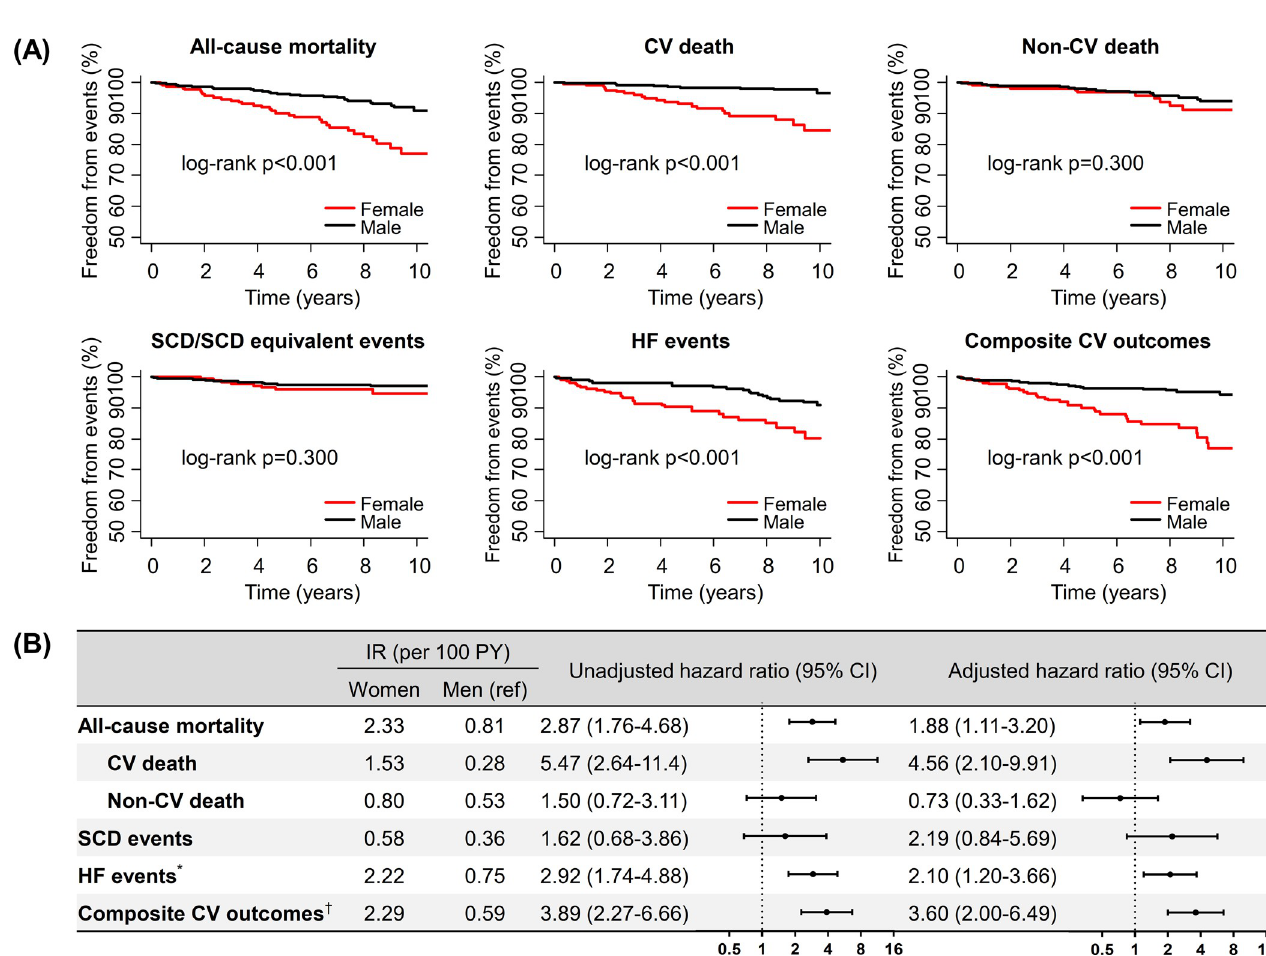
Fig 1. Sex differences in clinical outcomes. (A) Sex differences of event-free survival curves for clinical outcomes. (B) Independent association of sex with various outcomes. Multivariable adjustment was performed for age, body mass index, NYHA class, the SCD risk score, and left ventricular ejection fraction. � HF events = Admission for HF + Heart transplantation + Death due to HF + Progression to NYHA functional class III/IV. † Composite CV outcomes = CV death + SCD/SCD equivalent events + Admission for HF + Heart transplantation. CI, confidence interval; CV, cardiovascular; HF, heart failure; IR,